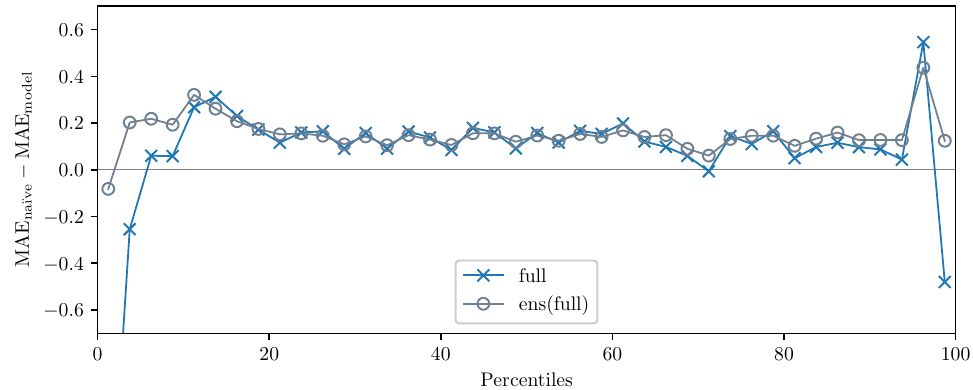
Figure 7. Differences in mean absolute errors across a range of price regimes: MAE naïve for model = ens(full) or full ; both with back-transformation (4). The x-axis represents percentiles of the marginal distribution of prices observed in the out-of-sample test period, with each point placed in the middle of the corresponding 2.5-percentile interval. The first point of the blue curve, that is, for observations between percentiles 0 and 2.5, is out of bounds since MAE naïve the extremely low